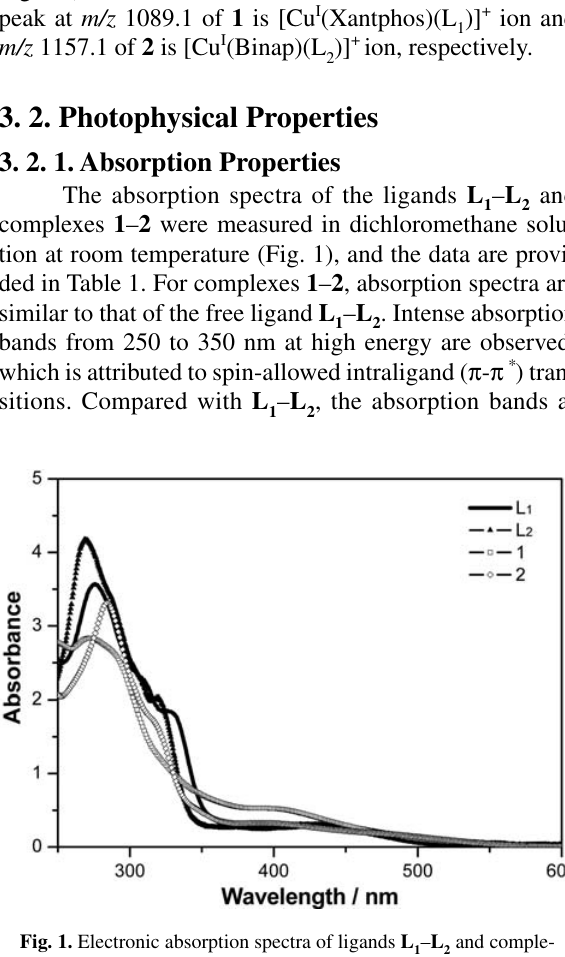
Cl at room temperature. 2 2